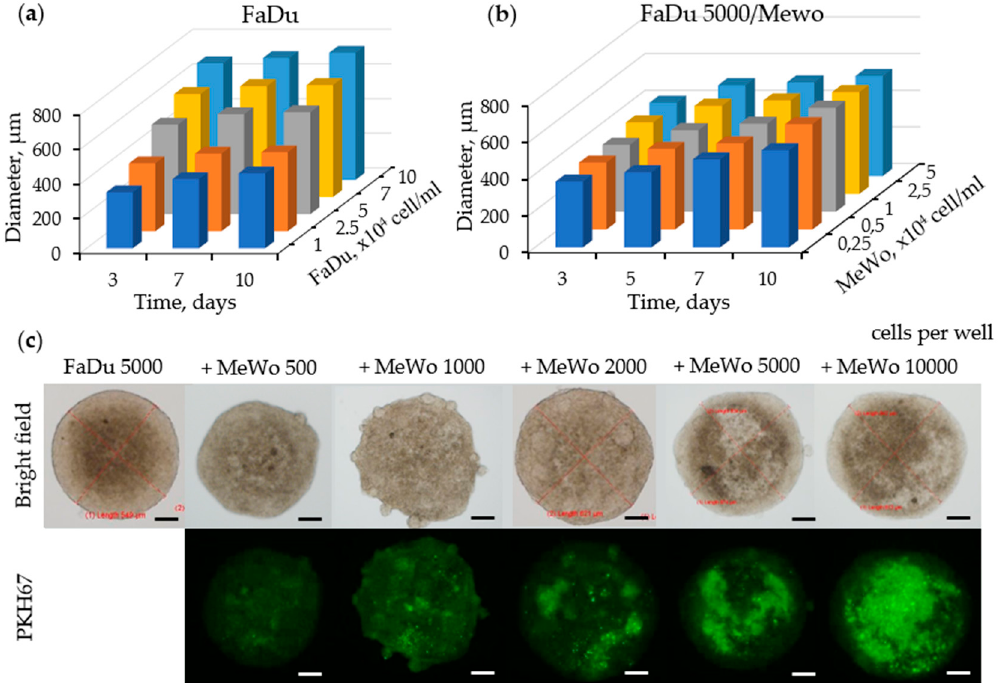
Figure 1. Spheroids characterization. Growth kinetics of ( a ) monoculture FaDu and ( b ) co-culture FaDu/MeWo multicellular spheroids. ( c ) Representative optical and fluorescence imaging of co-culture FaDu/MeWo multicellular spheroids captured on day 5 after seeding. Scale bars: 100 µm.